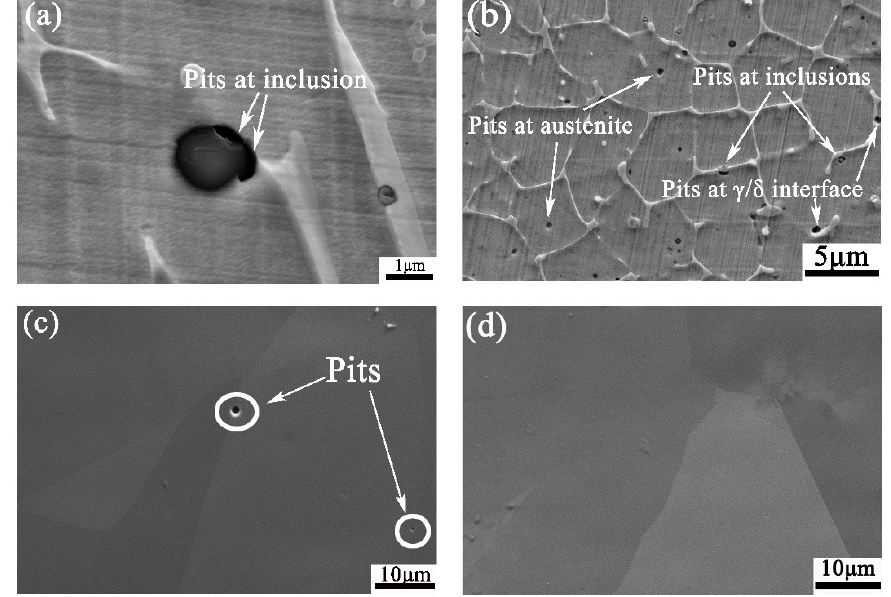
Figure 10. Local corrosion morphologies for ( a ) and ( b ) 308L WM, ( c ) 316L HAZ, and ( d ) 316L BM.